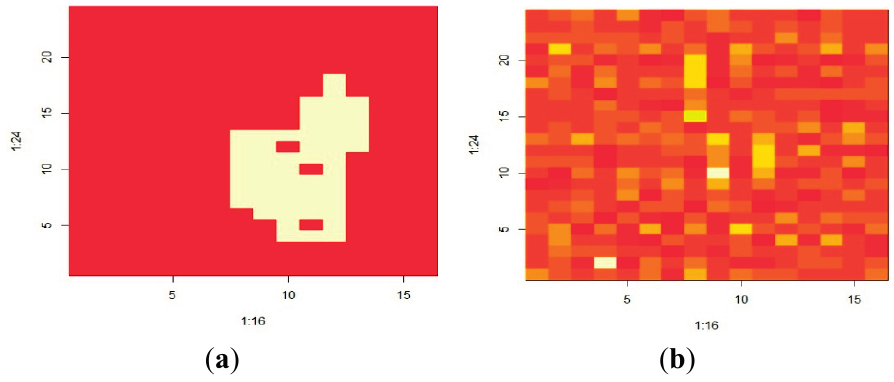
Figure 2. Illustration of reference labeling and corresponding feature values. The image is 16 × 24 elements, where each element represents a 16 × 16 pixel patch in the original image of 256 × 384 pixels from [8]. ( a ) The Y labels (0 = red for natural, 1 = white for manmade); ( b ) The corresponding X values represented using a scalar (projection of X onto the first eigenvector of the covariance matrix of X ; i.e. , the first principle component scores; see Section 3). ( a ) Y values by pixel: Red is “natural” (0) White is “manmade” (1); ( b ) Scalar representation of X values at the same pixels as in plot ( a